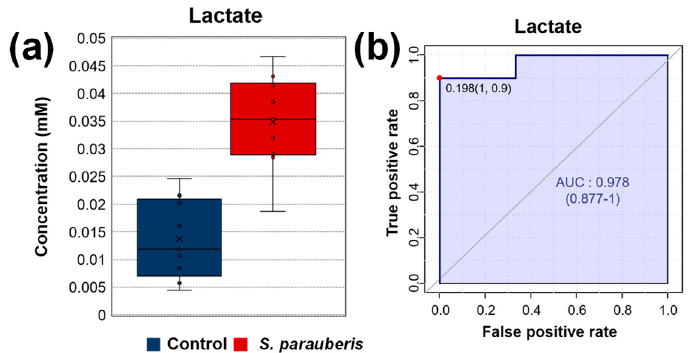
Figure 1. ( a ) Concentrations of lactate as potential biomarker identified through NMR spectroscopy. ( b ) ROC analysis result for lactate. Table 1. Comparison of lactate concentration in the spleen of control and S. parauberis- infected olive flounder. Concentration (mM, Mean ± Metabolite